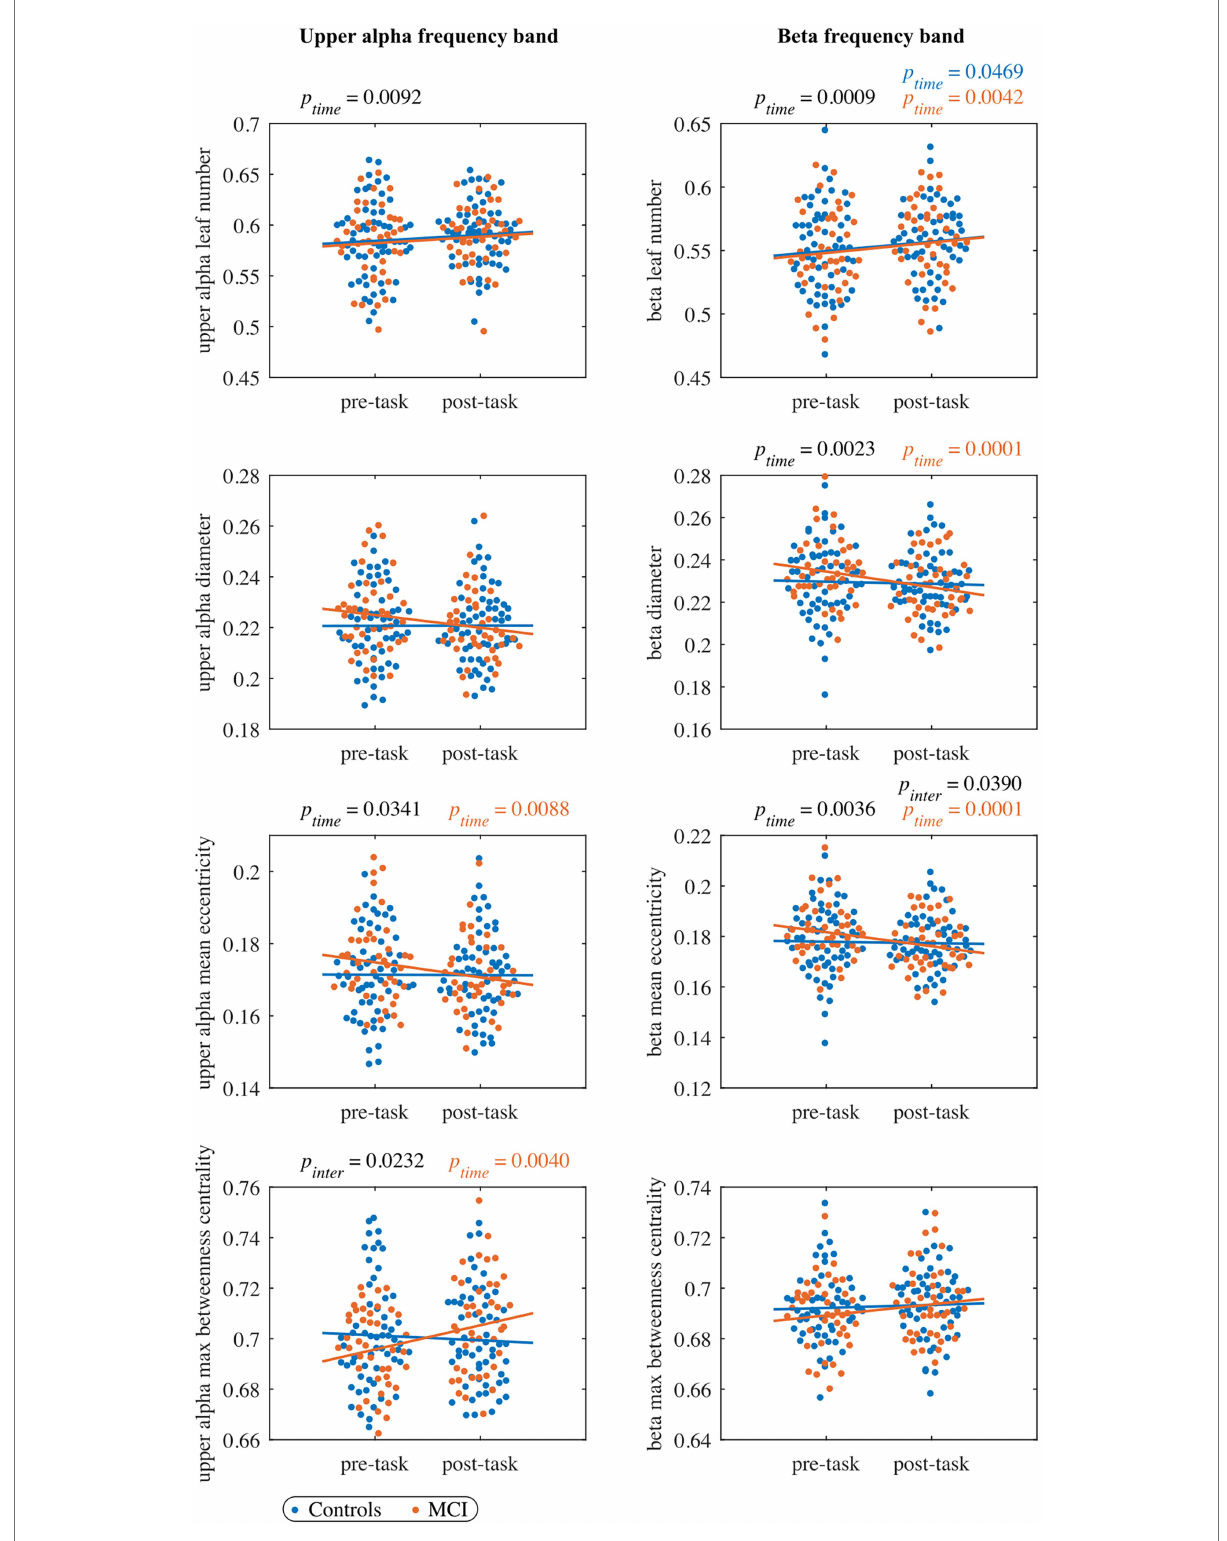
FIGURE 3 The pre- and post-task MST measures in the upper alpha band (left column panels), and beta band (right column panels). Each dot represents the value of one subject at pre-/post-task timepoint (blue: control, orange: MCI). The black p time and p inter values indicate significant timepoint and interaction effects, respectively, of the LMM fitted to the whole cohort (no significant group effects were observed). The blue and orange lines represent the fit of the LMM fitted to the control and MCI group, respectively. The orange p time values indicate significant timepoint effects of the LMM fitted to the MCI group (no significant effects were observed in the control group). All the reported p values are